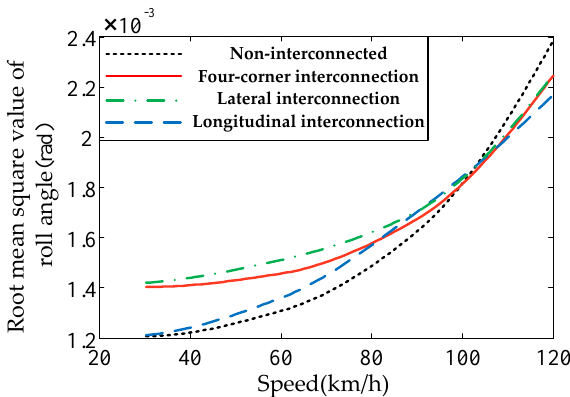
Figure 8. Root mean square (RMS) value of roll angle under the straight condition.